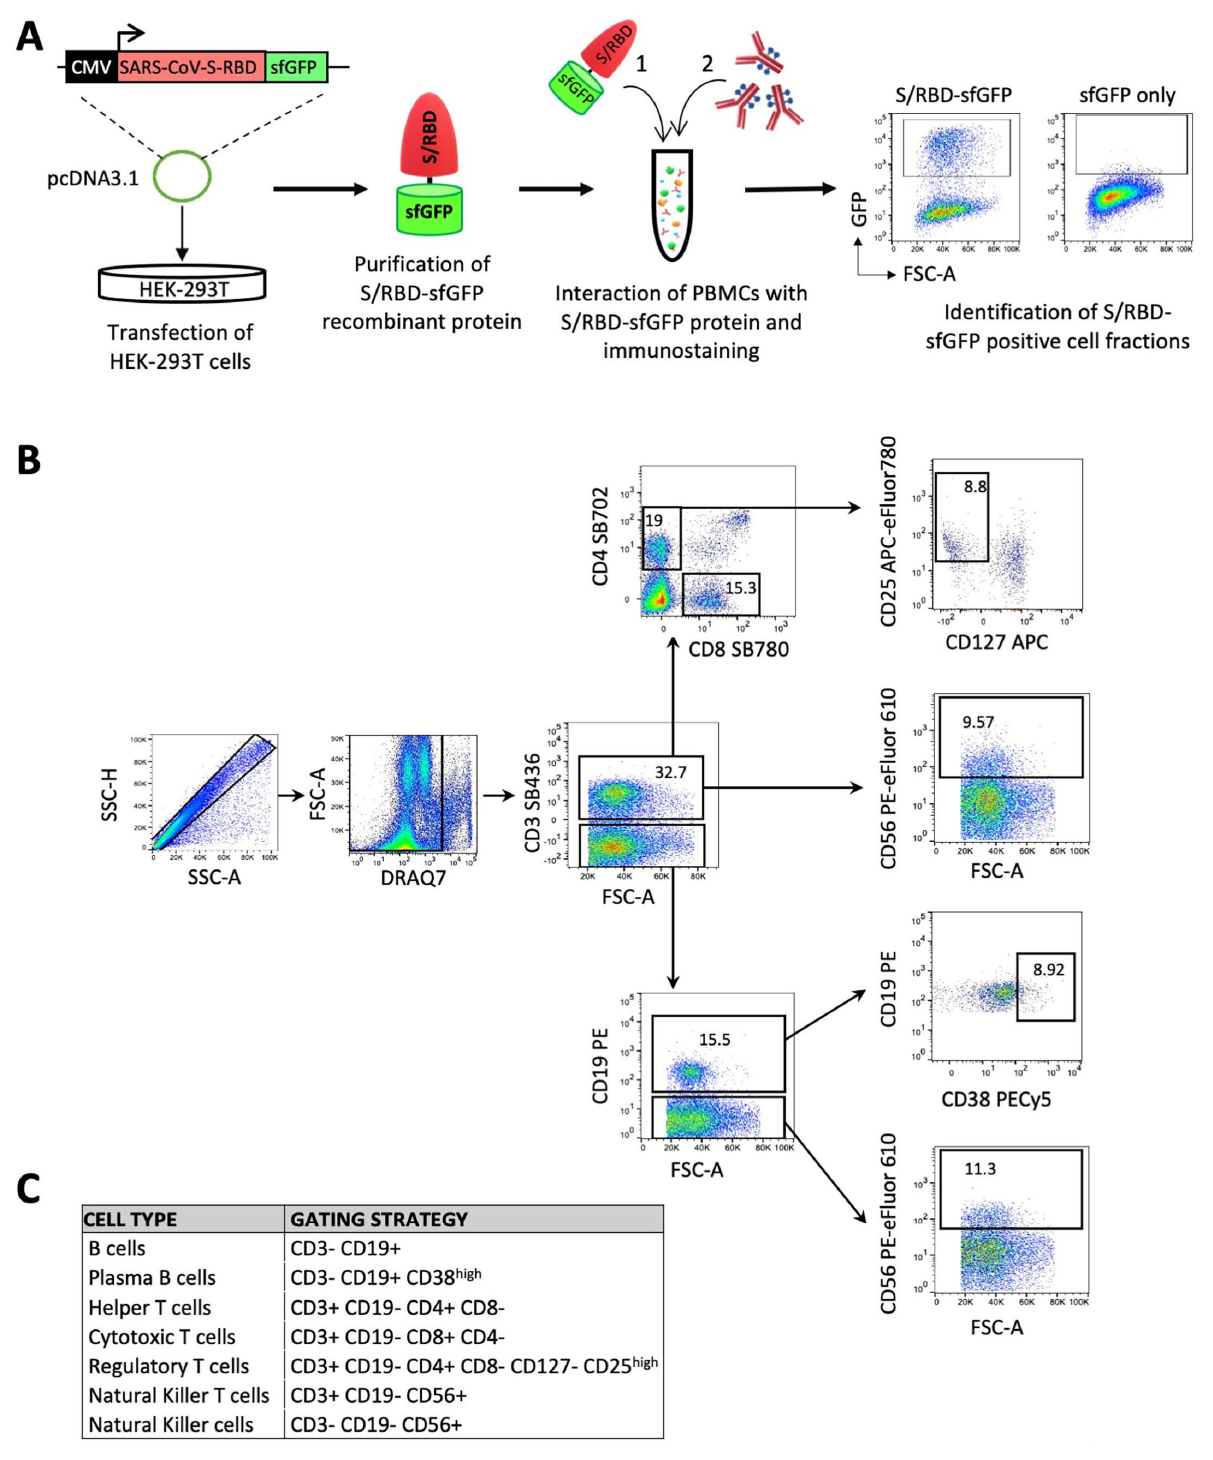
Figure 1. Immunophenotypic characterization of peripheral blood mononuclear cells (PBMCs) in response to